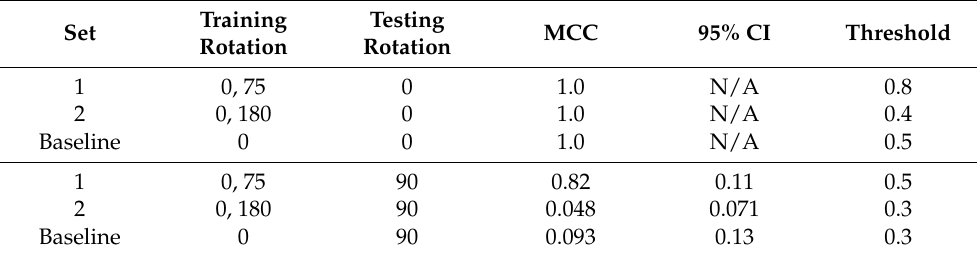
Table 8. X-band results tabulating unet model training data, testing data, the peak MCC performance with 95% confidence interval (CI), and the corresponding